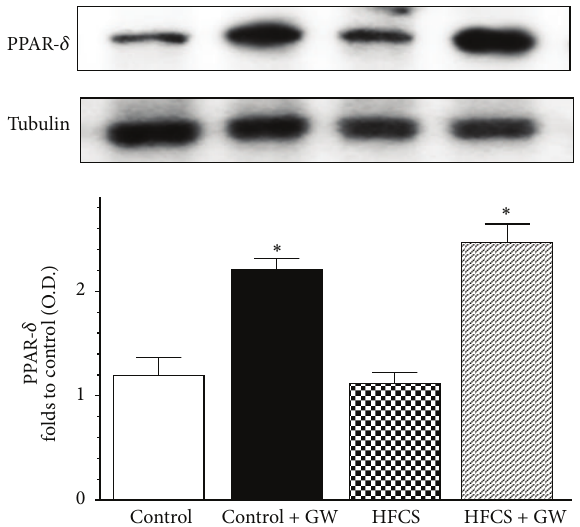
Figure 1: Effects of dietary manipulation and GW0742 treat- ment on PPAR- 𝛿 expression in the mouse gastrocnemius. Protein expression was measured by western blot analysis in gastrocnemius homogenates of mice fed with a standard (control) or HFCS diet (HFCS) in the absence or presence of GW0742 treatment (1mg/kg/day) (control + GW; HFCS + GW). Densitometric analysis of the bands is expressed as relative optical density (O.D.), corrected for the corresponding tubulin, and normalized using the related control band. Data are means ± SD of three separate experiments. ∗ 𝑃 < 0.01 versus